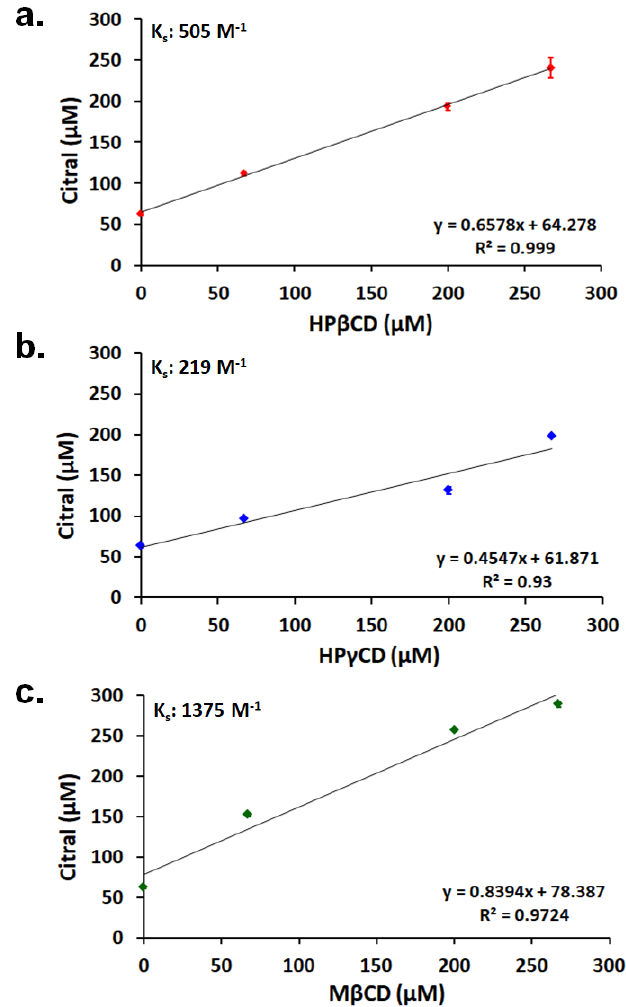
Figure 2. Phase solubility diagram of ( a ) citral/HPβCD, ( b ) citral/HPγCD, and ( c ) citral/MβCD systems in water ( n = 3).